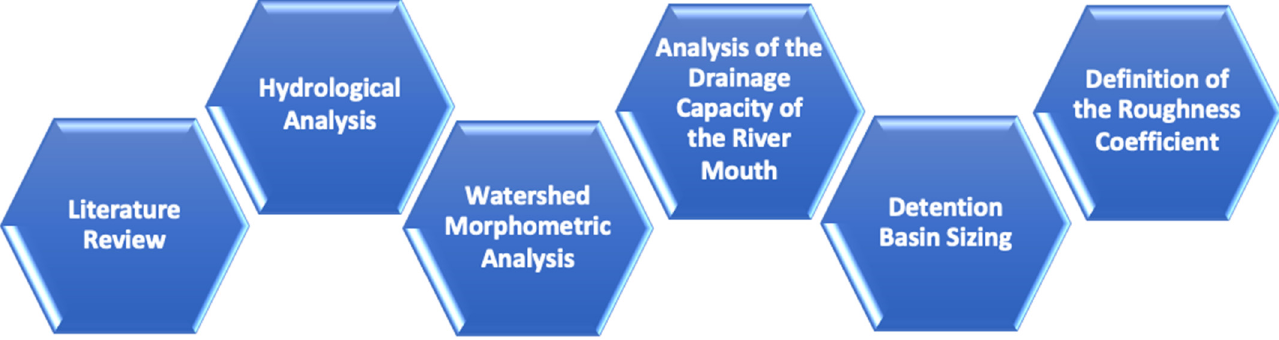
Figure 3. Organogram of the adopted methodology.